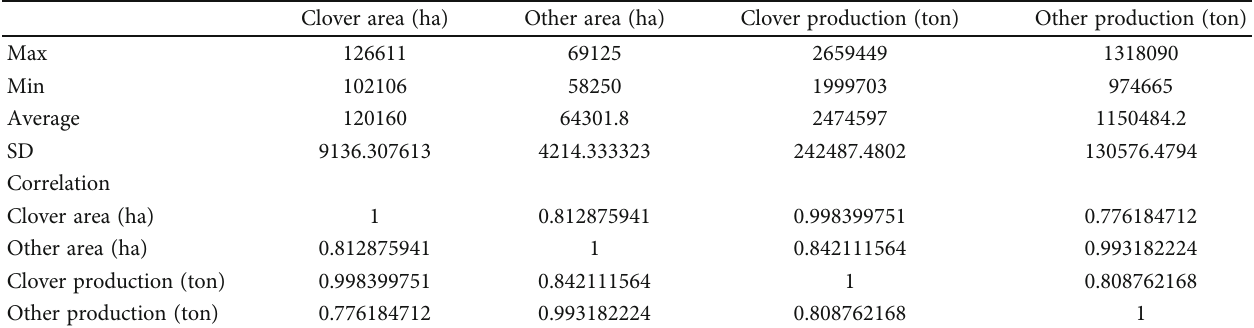
Table 6: The statistics and correlation on input/output data of VRS-DEA model (2). Clover area